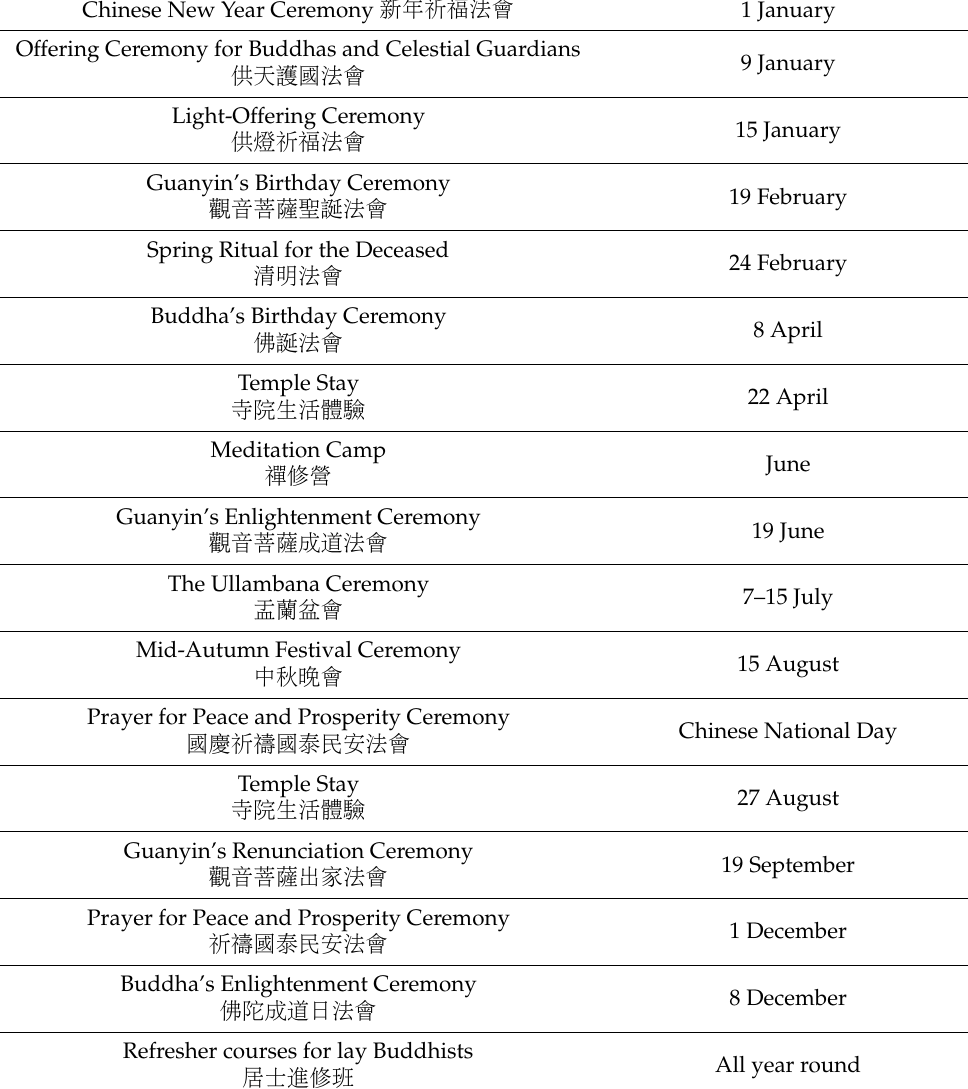
Table 2. The calendar of the Wenshu Monastery (lunar